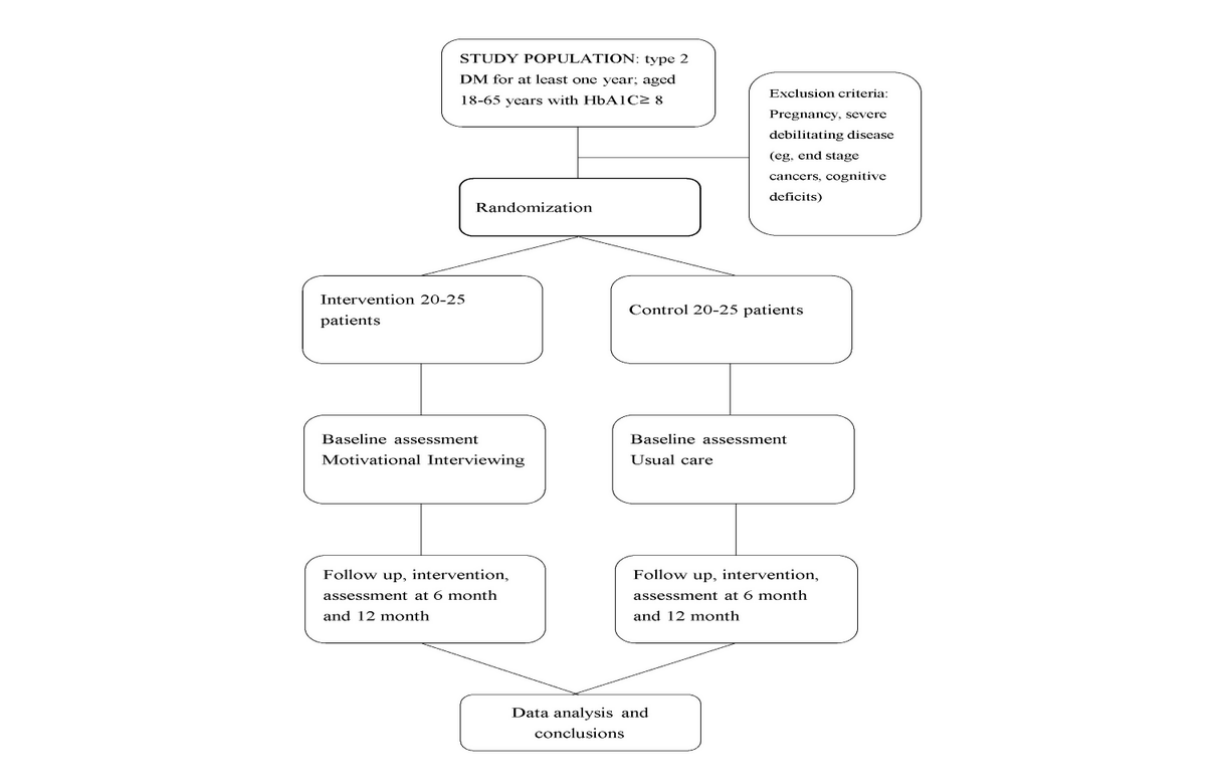
Figure 1. Trial participant flow. DM: diabetes mellitus; HbA 1c : glycated